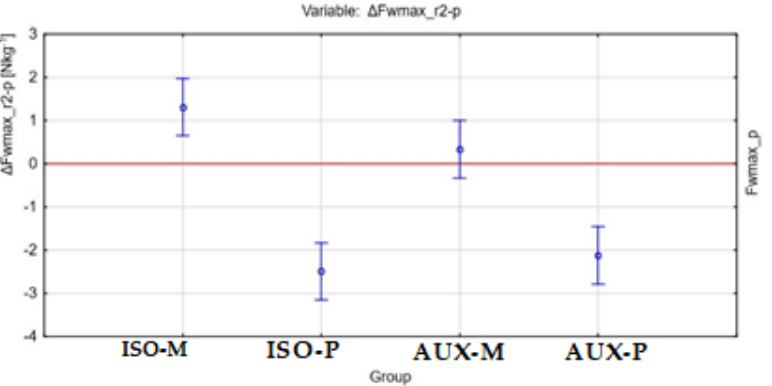
Figure 5. Graphical representation of the results of ANOVA Kruskal–Willis analysis for the ΔFwmax_r-p variable between all tested groups of participants.